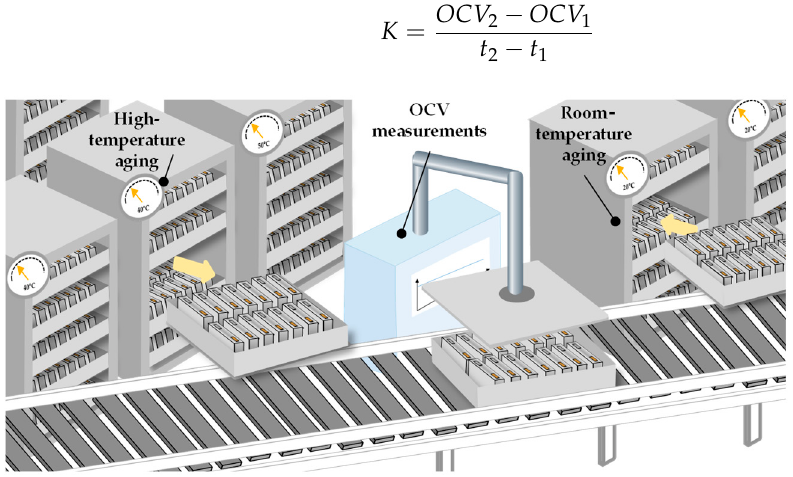
Figure 7. Schematic of high-temperature and room-temperature aging [9] .